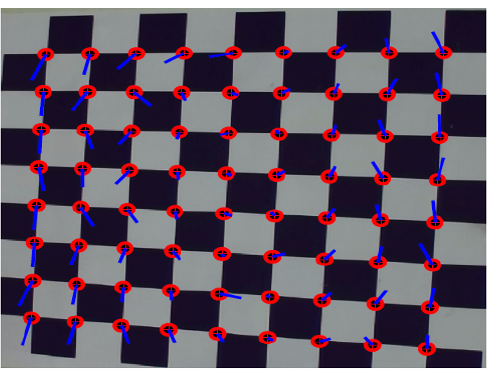
Figure 16. Residuals from the check data, magnified with a factor of